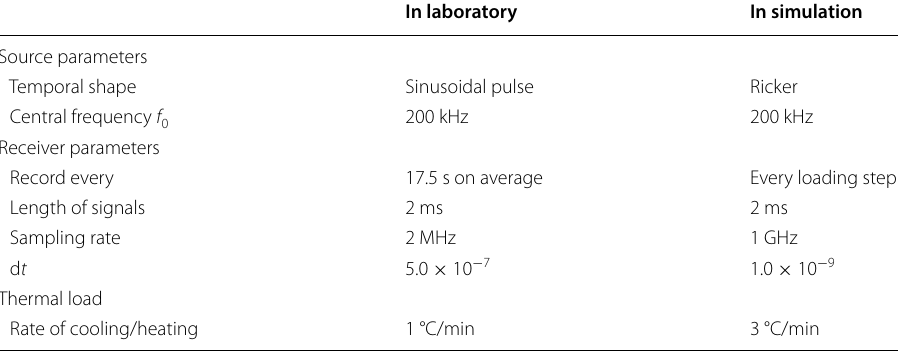
Table 1 Parameters of the sensors and source function used in the laboratory experiments (S9215 high temperature sensors from Physical Acoustics) and in the simulation with heating and cooling